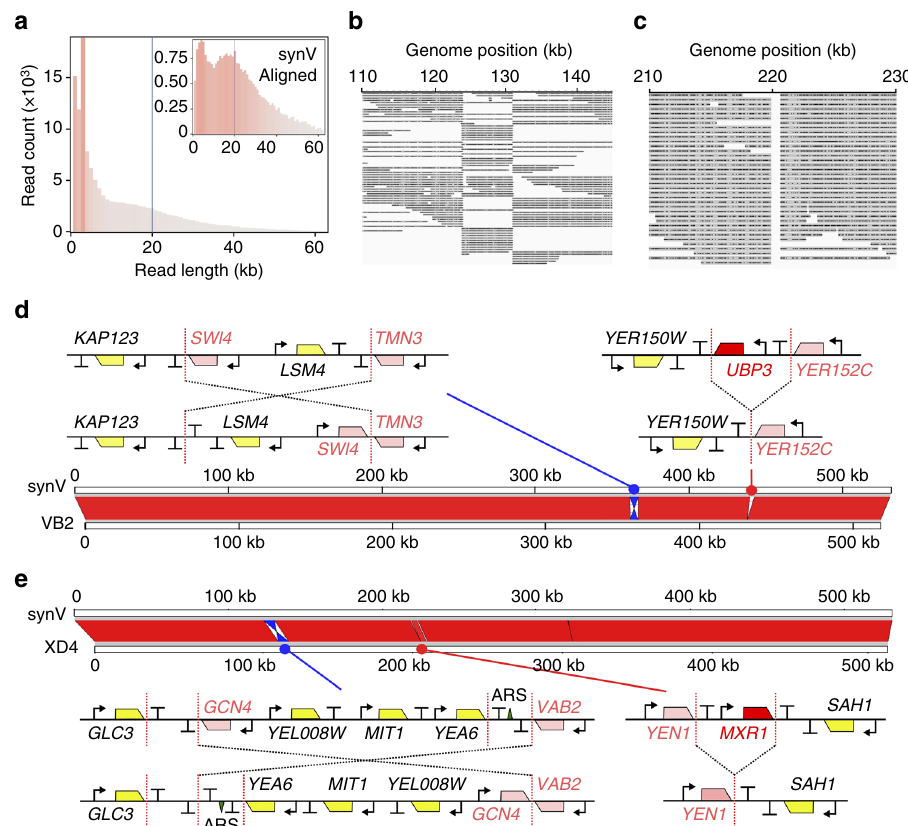
Fig. 3 Nanopore sequencing to identify the SCRaMbLE events in enhanced strains. a Base-called read length distribution of the XD4 nanopore sequencing run. The line at 20 kbp indicates the DNA shear length during library preparation. Inset is the same analysis of the subset of the data that aligned by LAST to the synthetic chromosome V sequence. b An alignment of XD4 nanopore sequencing reads to parental synV sequence around the identi fi ed inversion region. c An alignment of XD4 nanopore sequencing reads to parental synV sequence around the identi fi ed MXR1 deletion region. d Full alignment of the VB2 contig, and e the alignment of the XD4 contig to the parental synV. The inversion and deletion regions are expanded to show diagrammatic interpretations of the SCRaMbLE events, showing pre- (top) and post-SCRaMbLE (bottom) con fi gurations, with locations of promoters (arrows), coding sequences (polygons), terminators (T), autonomous replicating sequences (ARS, triangle) and loxPsym sites (red dotted lines) indicated. Red coding sequences are deleted by SCRaMbLE events and pink coding sequences have their 3 ′ UTR regions